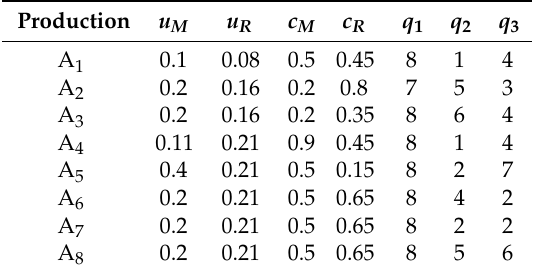
Table 2. Parameters of Simulation